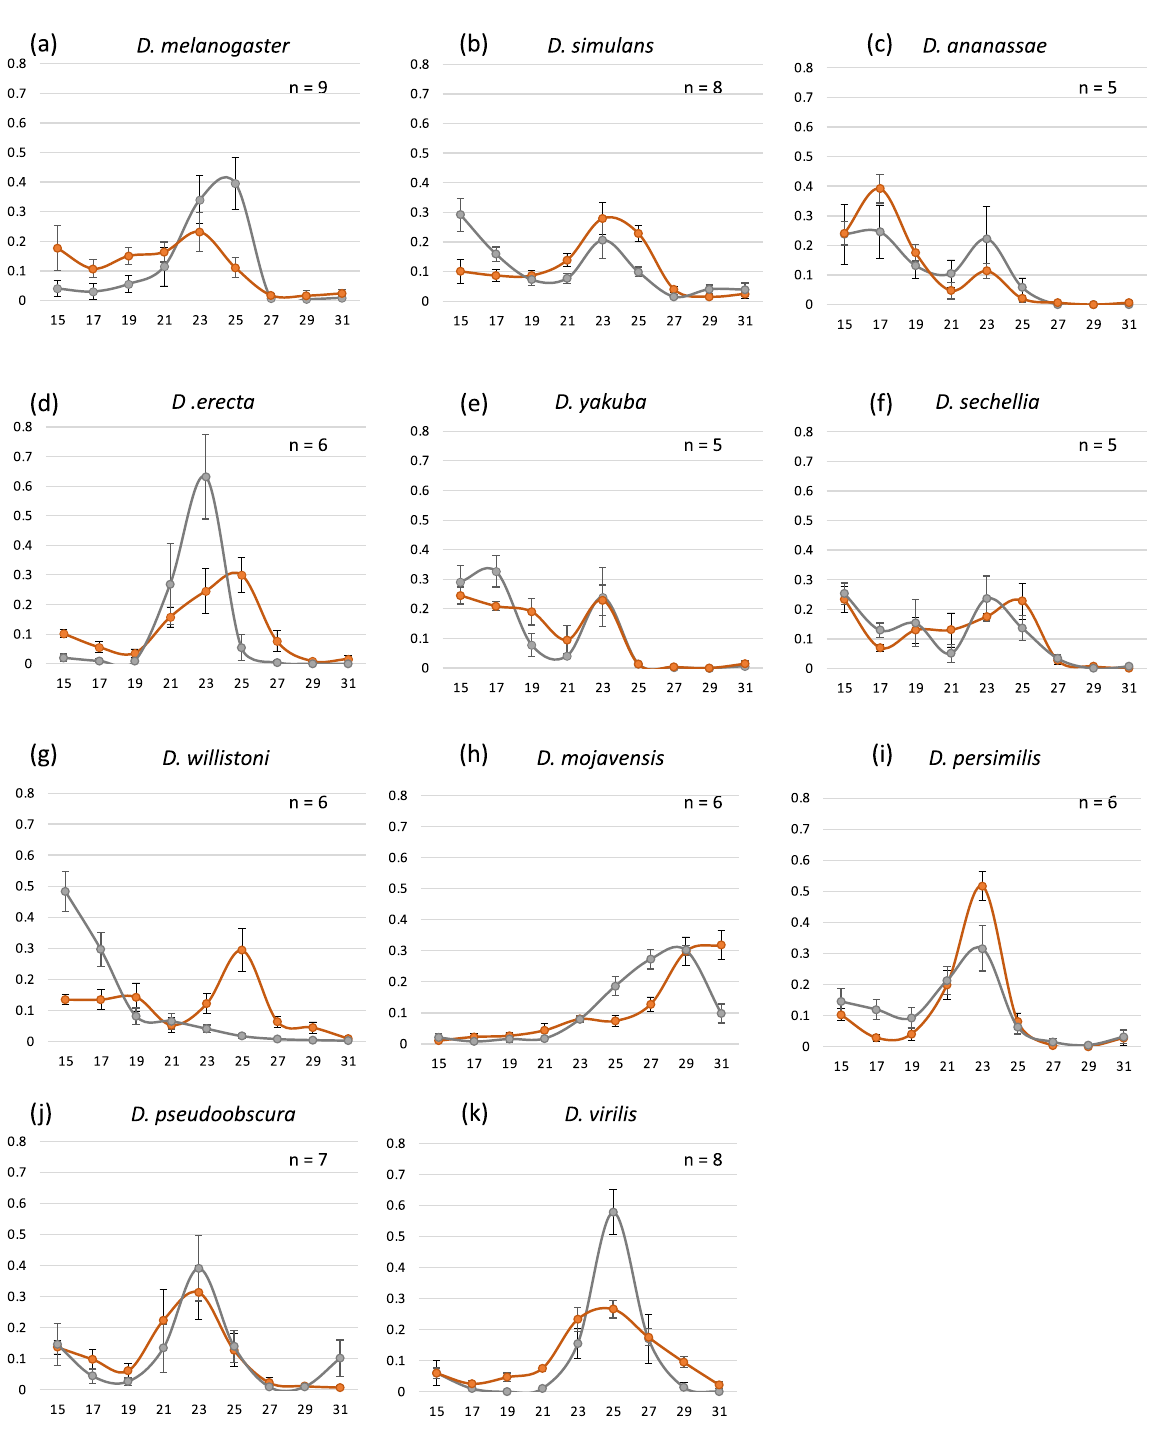
Figure 7. Temperature preference of 11 Drosophila species with antenna ablation. ( a–k ) The distribution of control (gray line) and antenna ablated (orange line) flies on the temperature gradient field in each species; ( a ) D. melanogaster , ( b ) D. simulans , ( c ) D. ananassae , ( d ) D. erecta , ( e ) D. yakuba , ( f ) D. sechellia , ( g ) D. willistoni , ( h ) D. mojavensis , ( i ) D. persimilis , ( j ) D. pseudoobscura , and ( k ) D. virilis . Error bars indicate standard error of